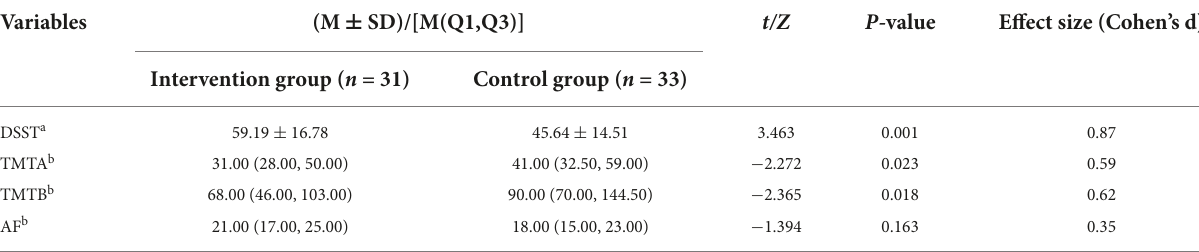
TABLE 3 Comparison of cognitive function between the intervention group and the control group after intervention.